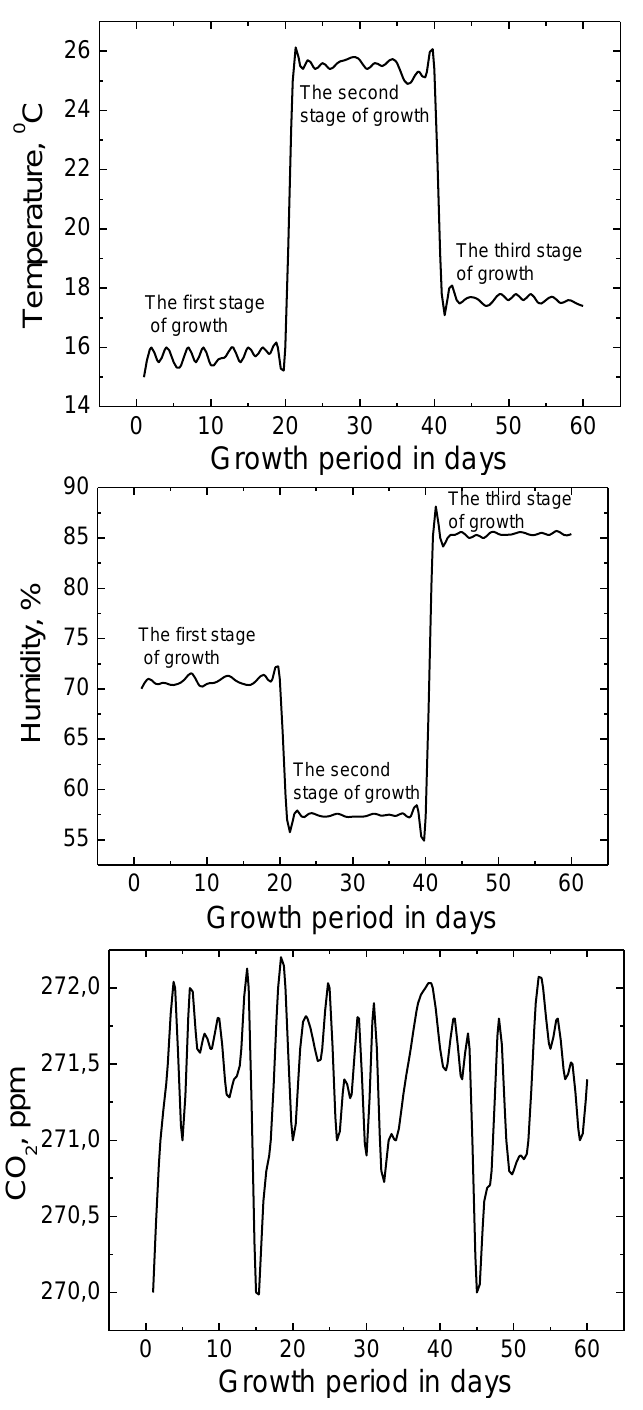
Figure 14. Changes in temperature, humidity and CO 2 parameters during the growth cycle of cham- pignons.